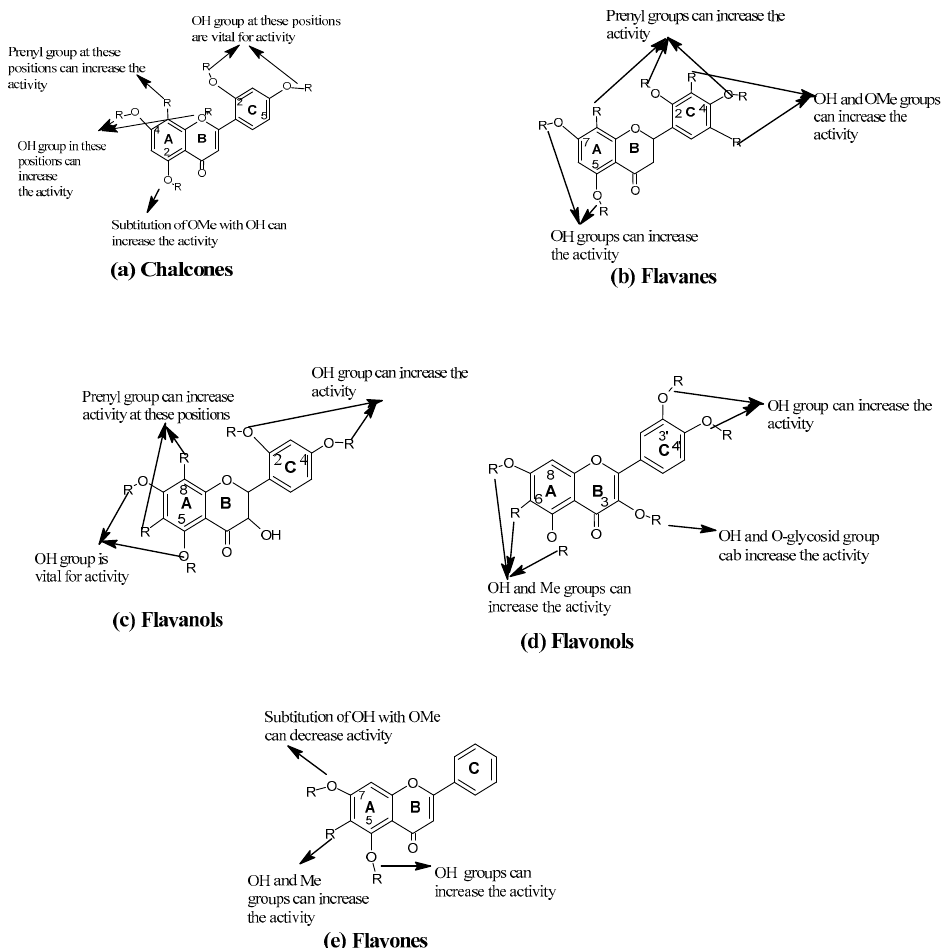
Figure 1. Structure–activity (SAR) relationship of important flavonoids: ( a ) in chalcones, substitution of OMe, OH, and prenyl group in ring A, OH group in ring B, and OH groups in 2 (cid:48) and 4 (cid:48) position of ring C enhances antimicrobial activity; ( b ) on flavanes, substitution of prenyl and OH groups at 5 (cid:48) and 7 (cid:48) positions in ring A and OH, OMe groups at 3 (cid:48) and 5 (cid:48) position and prenyl at 4 (cid:48) position in ring C enhances antimicrobial activity; ( c ) in flavanols, substituting OH group at 5 (cid:48) position and prenyl at 8 (cid:48) position of ring A, and OH groups at 2 (cid:48) , 4 (cid:48) position can enhance antimicrobial activity; ( d ) in flavonols, replacing OH and Me group in ring A, OH, O-glycoside group in ring B and OH groups in ring C can improve antimicrobial activity; ( e ) In flavones substitution of OH group at 5 (cid:48) , OH, Me groups at 6 (cid:48) , and OH, OMe group at 7 (cid:48) of ring A can improve antimicrobial